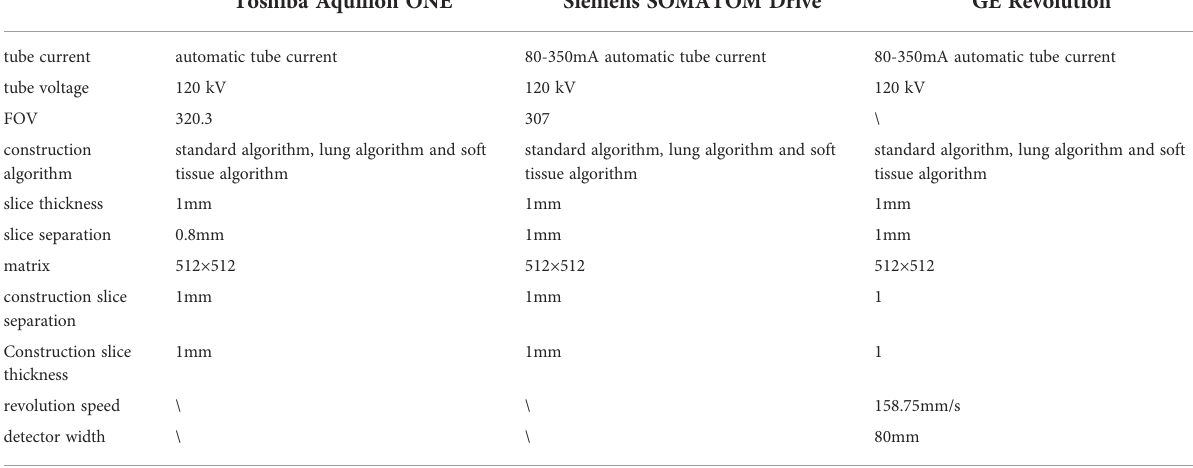
TABLE 1 Scanning parameters of the different CT scanners.